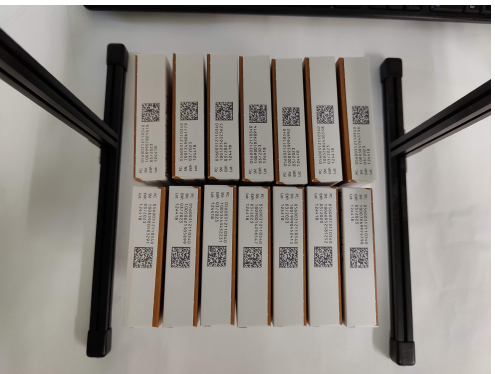
Figure 4. Acquired image from the camera according to a top-bottom perspective.